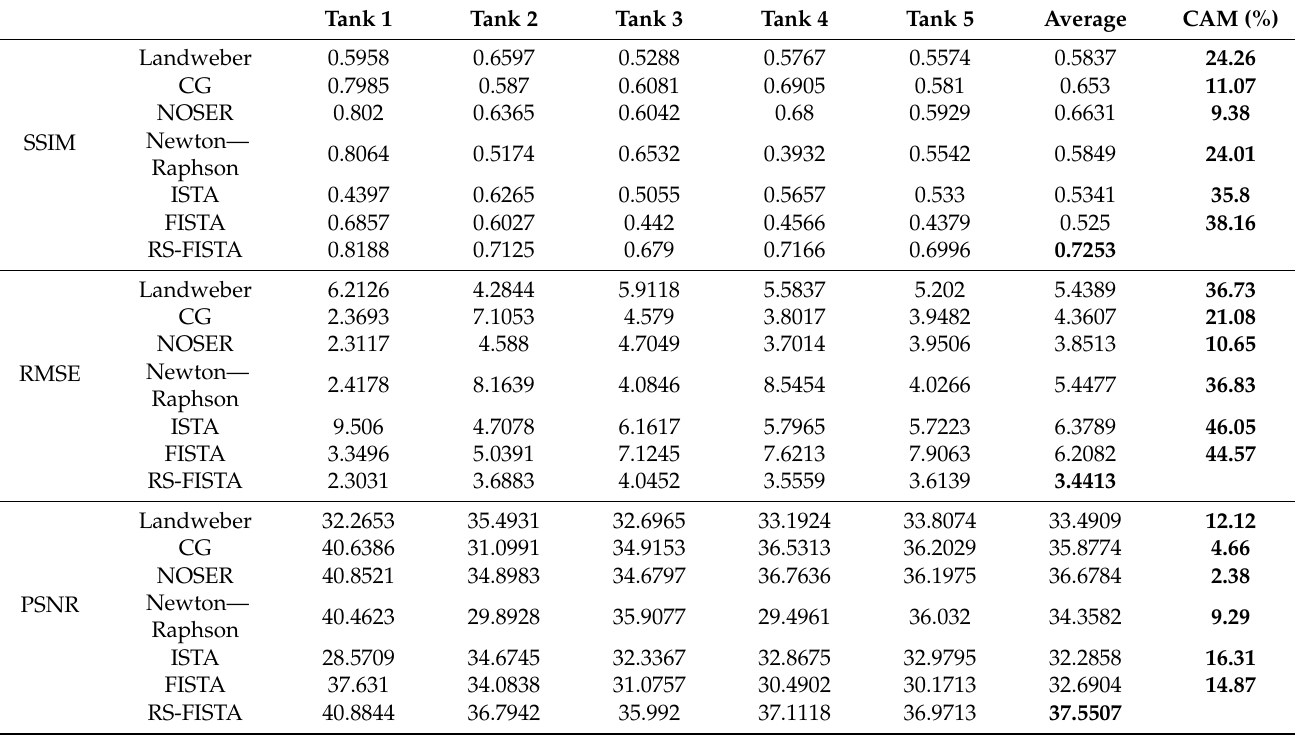
Table 2. Experimental evaluation metrics for imaging results of 7 different methods.